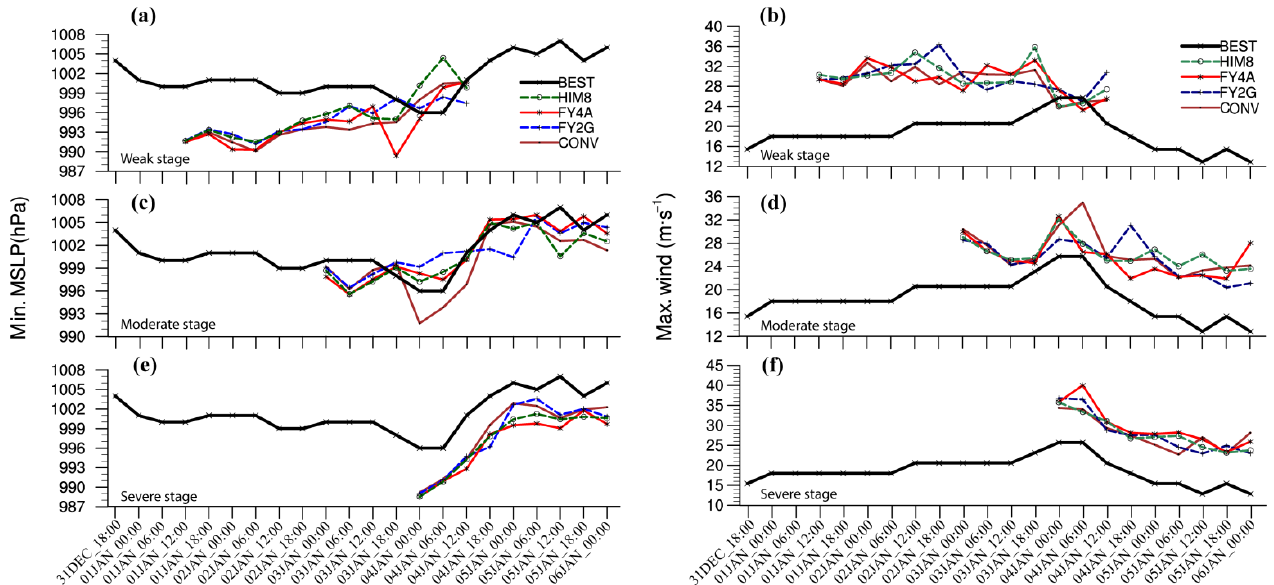
Figure 16. The temporal distribution of the observed from JTWC (black), and simulated for minimum MSLP of TC PABUK from CONV, FY2G, FY4A, and HIM8 experiments in the different stages for ( a ) 12:00 UTC 1 January 2019, ( c ) 00:00 UTC 3 January 2019 and ( e ) 00:00UTC 4 January 2019 with ( b , d , f ) for maximum wind speed, respectively.